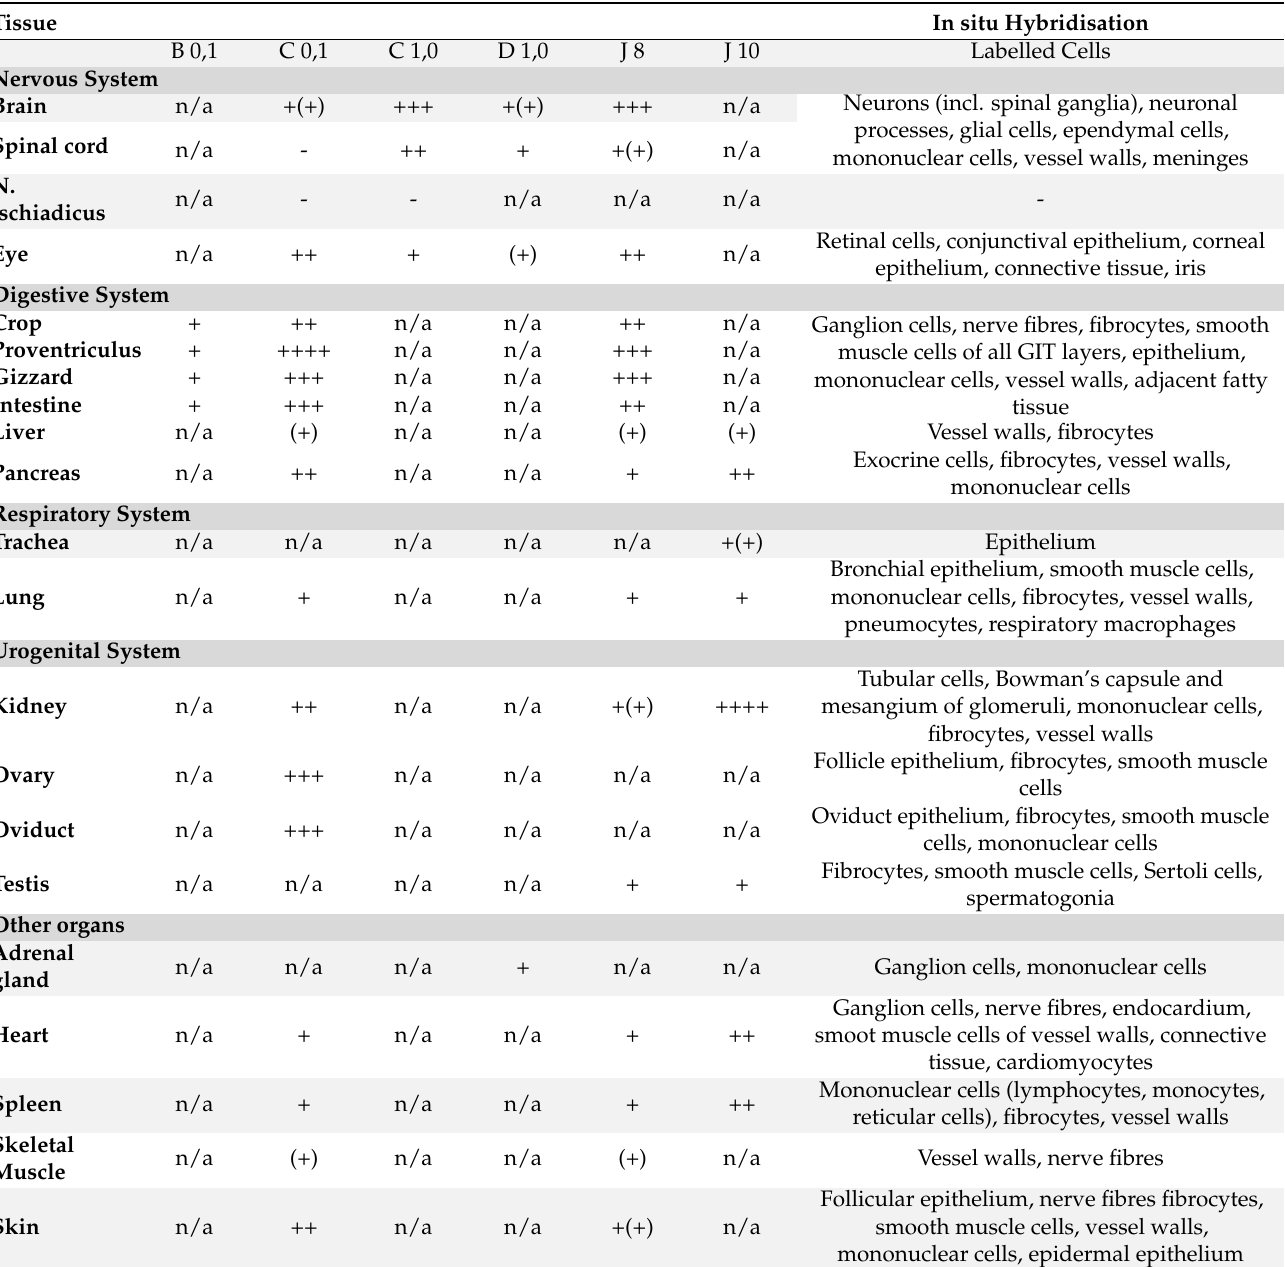
Table 4. Evaluation of in situ hybridisation (ISH) of PaBV-4 infected organs of four adult and two juvenile